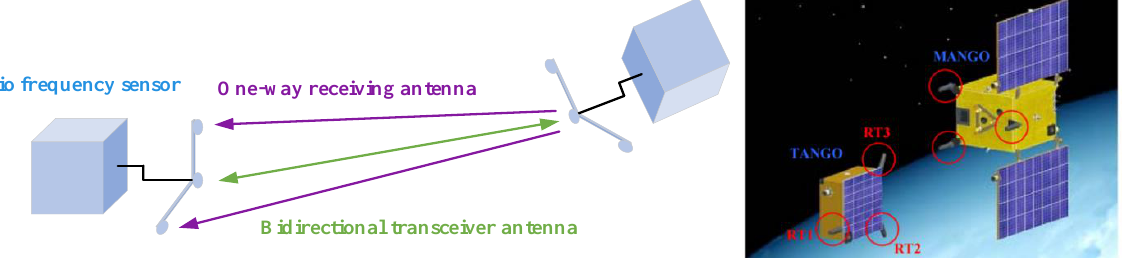
Figure 3. The relative-state measurement FFRF system; the antenna structure of PRISMA.